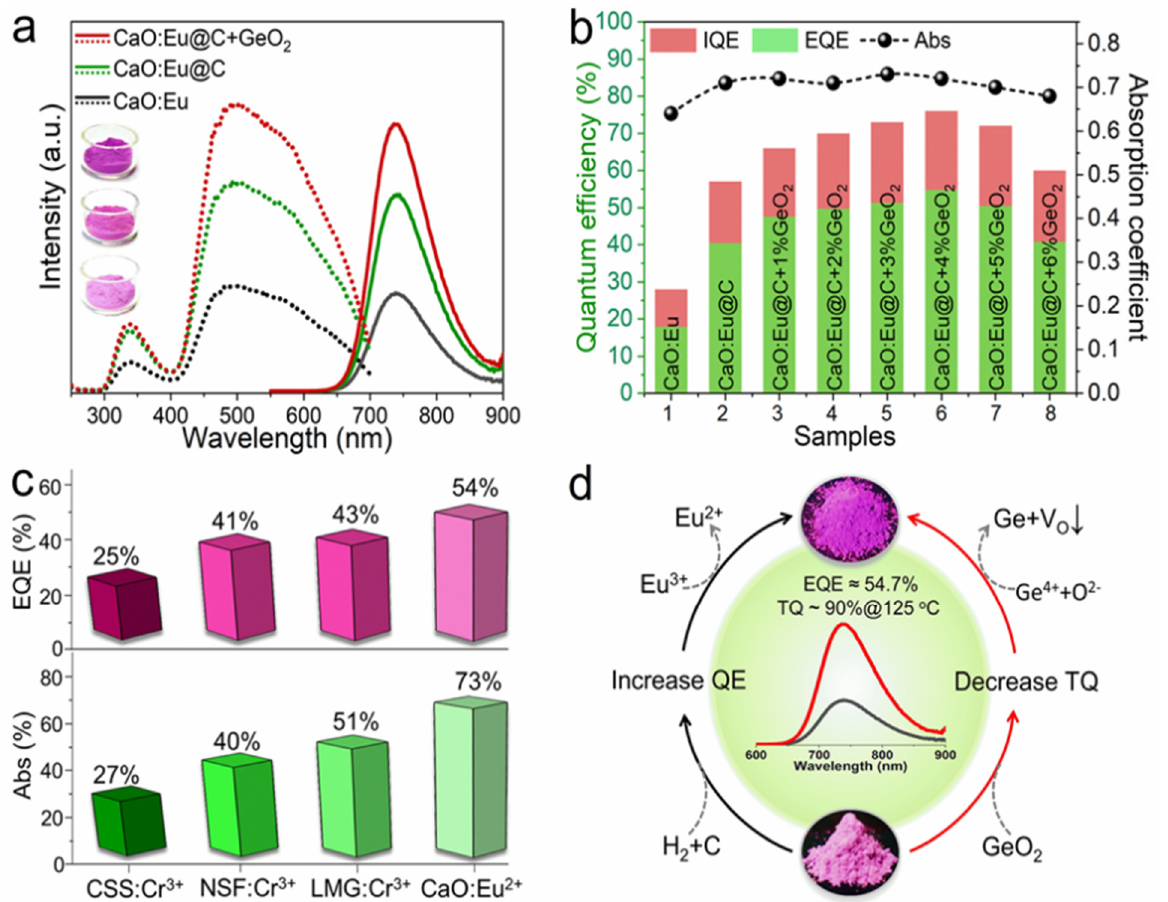
Figure 9. ( a ) Excitation and emission spectra of Eu 2+ phosphor under different treatment processes (Ex = 450 nm and Em = 740 nm). ( b ) Diagram of internal/external quantum efficiency and absorption efficiency. ( c ) Comparison of properties of several NIR phosphors. ( d ) CaO: Schematic diagram